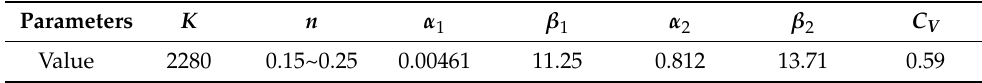
Table 3. Several parameters used in the FLO-2D